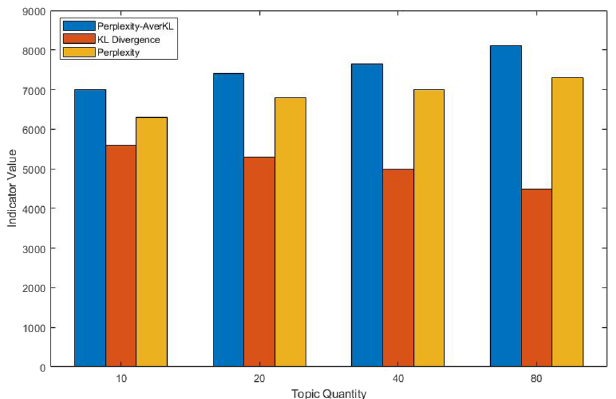
Figure 8. The efficacy comparison among Perplexity-AverKL, Perplexity and KL divergence while setting more topic quantity.